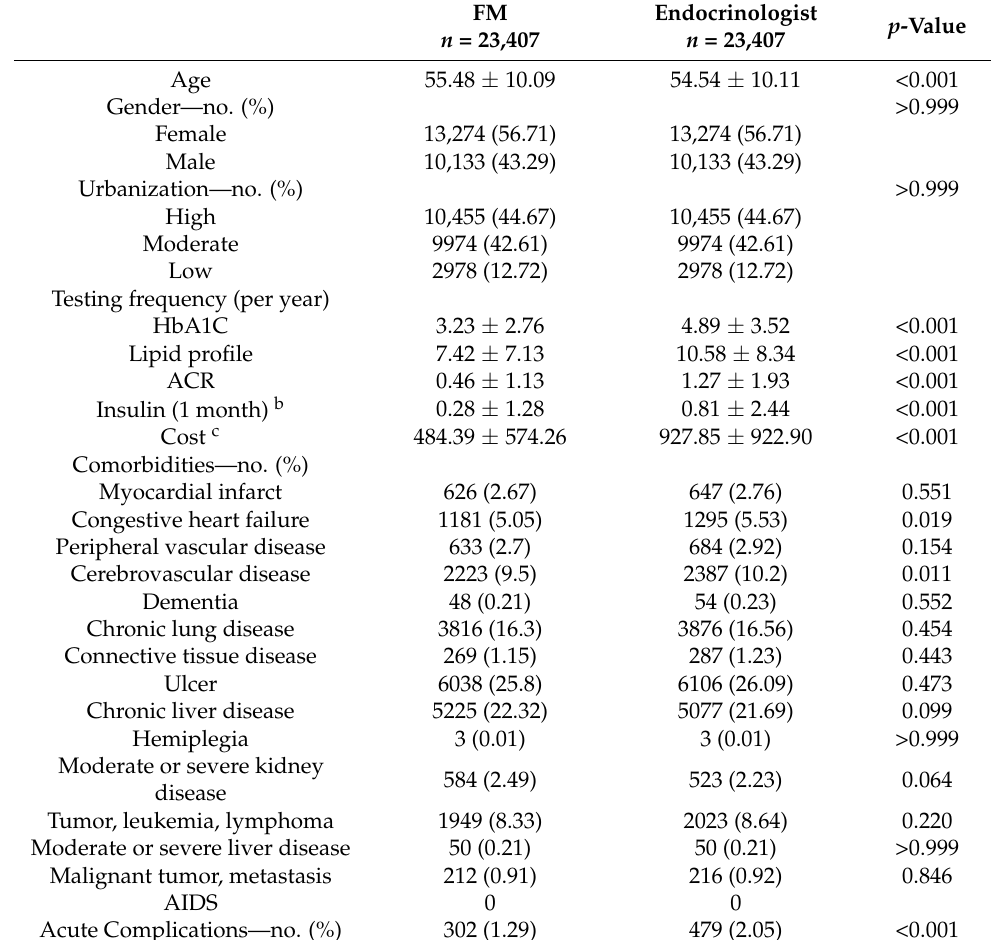
Table 2. Characteristics of the family medicine (FM) and endocrinologist cohorts a .